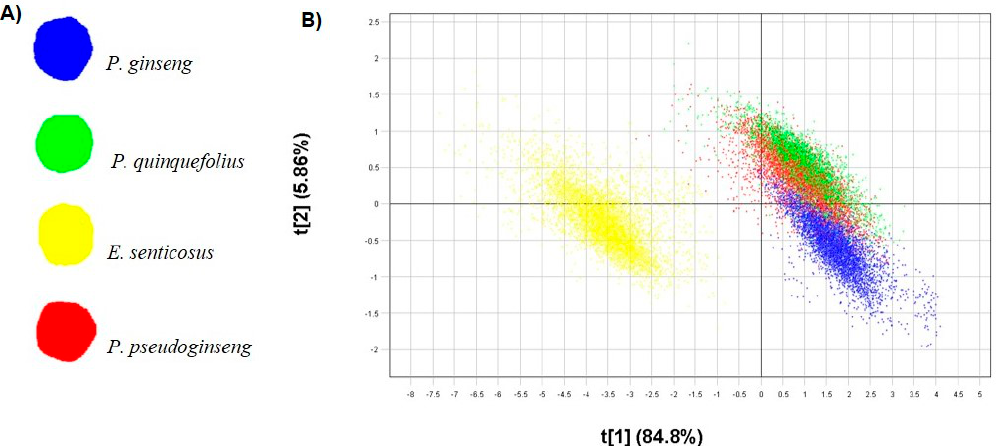
Figure 2. ( A ) PLS-DA Y-image of ginseng root powders colour-coded according to the species and ( B ) the corresponding pixel plot (PLS1 vs. PLS2) coloured according to the score values which correspond to the species in the score image.